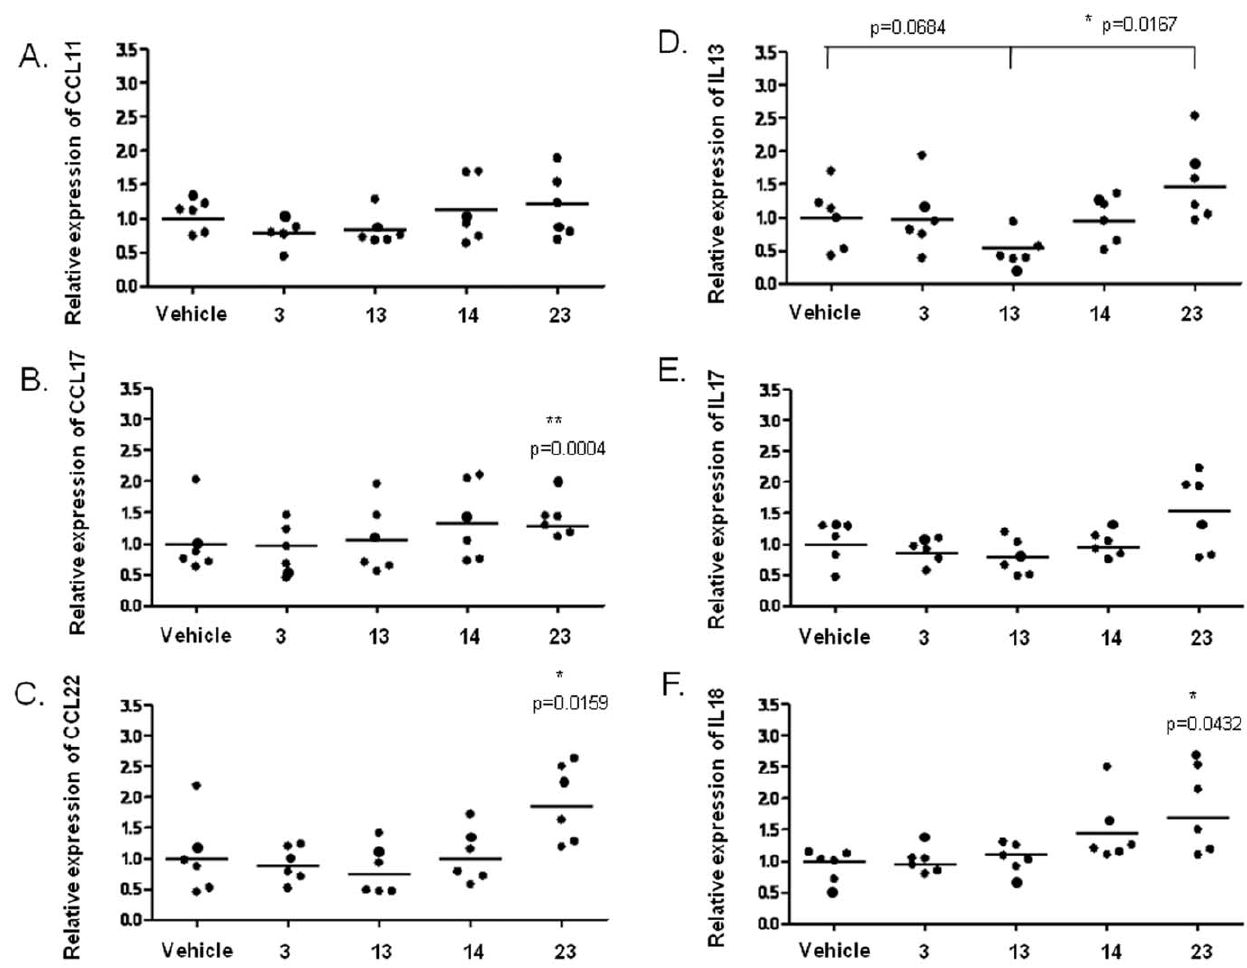
Figure 4. Expression of proinflammatory chemokines in the lungs of HLA-A*0201 transgenic mice immunized with CD8 epitopes and challenged with RSV. At day 4 post RSV challenge, lung RNA was extracted from the individual mice subcutaneously immunized twice with IFA-emulsified peptides or vehicle (IFA only). RNA was subjected to quantitative expression analysis of CCL11 (A), CCL17 (B), CCL22 (C), IL-13 (D), IL-17 (E), and IL-18 (F) by real-time RT-PCR using specific primers. GAPDH was used as internal control. The results are representative of the relative expression of the target gene normalized to GAPDH expression for the individual mouse. *(p , 0.05) indicates the treatment is significantly different from the vehicle-immunized control. Similar results were obtained from two independent experiments, each with six mice per group, and one of them is shown.